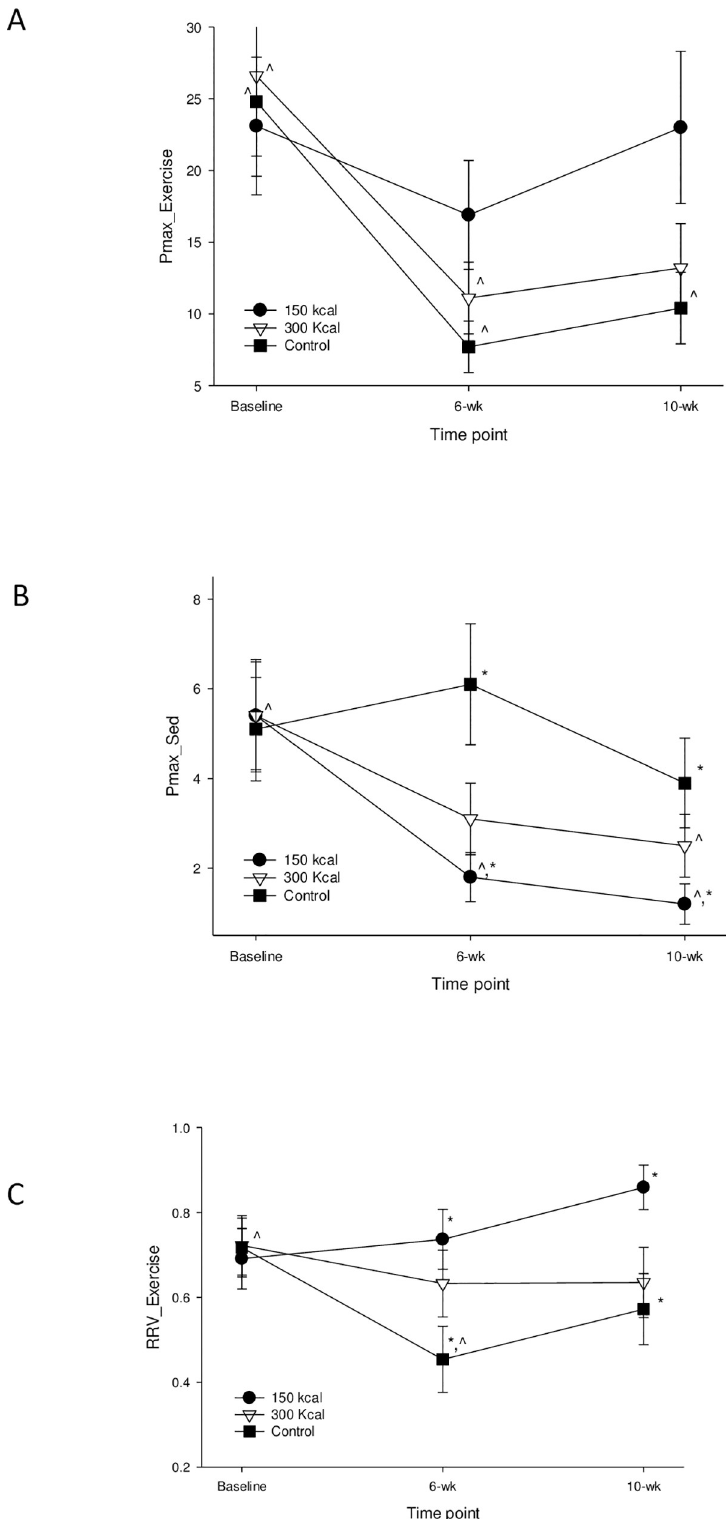
Fig 2. Changes in exercise and sedentary behavior reinforcement and relative reinforcing value of exercise over 10 weeks. Reinforcing value of exercise (Pmax of exercise, A), Pmax of sedentary activities (B), and relative